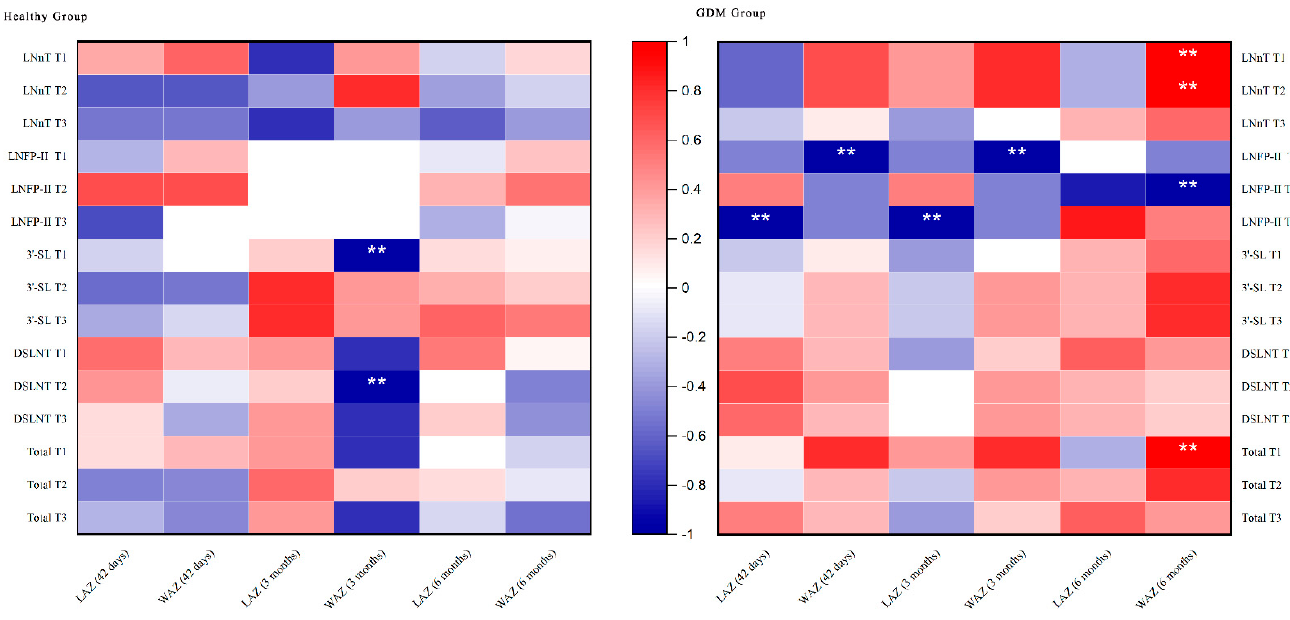
Figure 3. Spearman rank correlations between infant growth indicators and individual HMO concentrations in the two groups of the secretory type. T1, T2, and T3 represent colostrum (within 7 days), transitional milk (12–14 days), and mature milk (42 days), respectively; ** represents the correlation is significant at the 0.01 level (two-tailed).